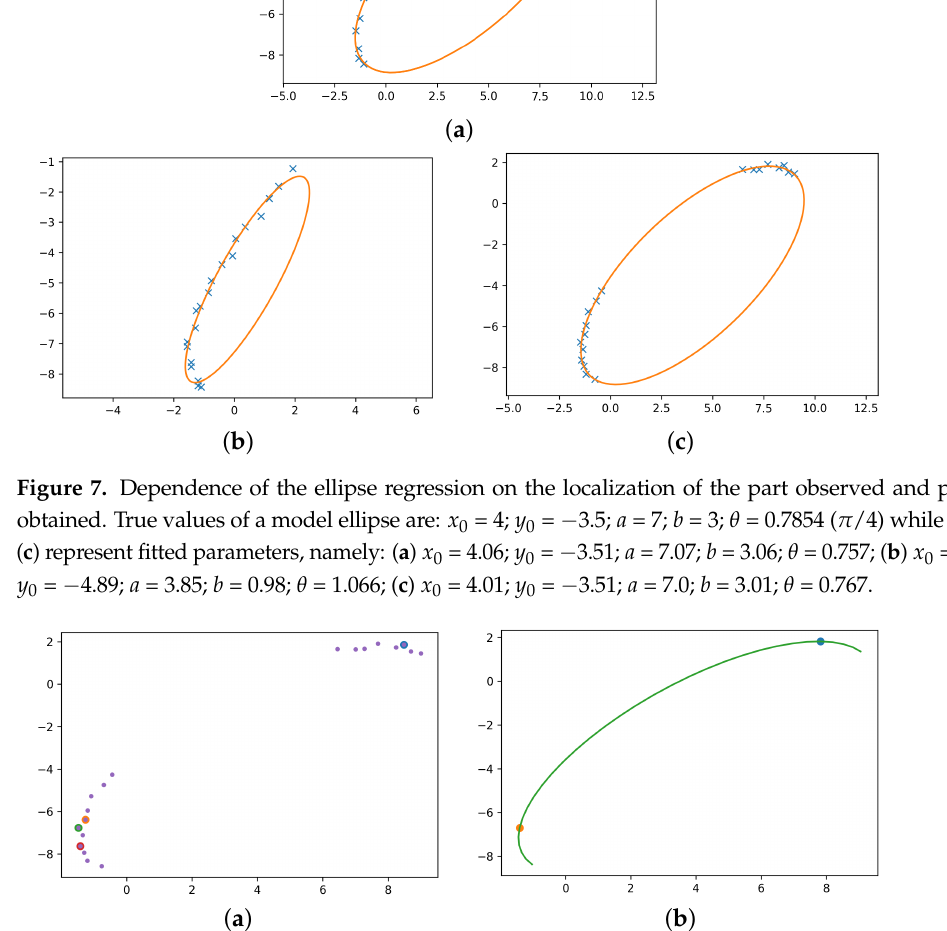
Figure 8. Highlighted points of derivative sign changes of ( a ) the ellipse with noise and ( b ) the smoothed one. As a result it might indeed be reasonable to weigh estimated ellipses according to how much information they have. However, it was not used in the current CVV method since it would make the method more complex and it already shows sufficient efficiency as shown in the following sections.